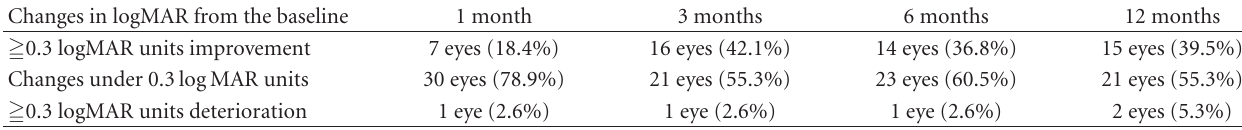
IVR: intravitreal injection of ranibizumab, PDT: photodynamic